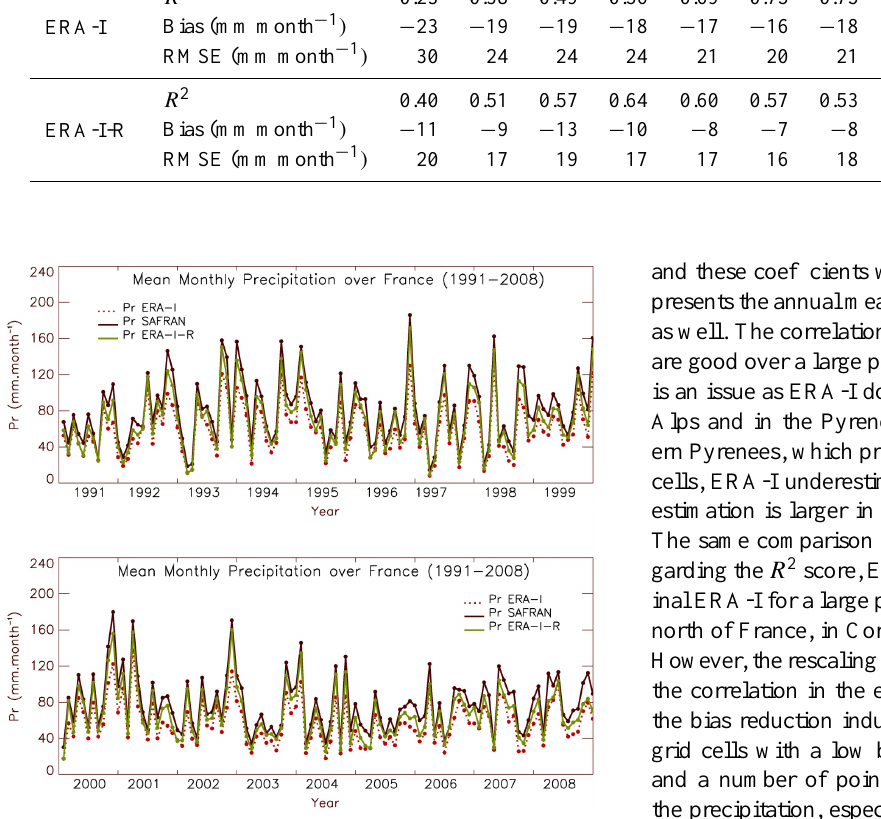
Fig. 3. Mean monthly precipitation over France for SAFRAN, ERA-I and ERA-I-R over the period 1991–2008: from (top) 1991 to 1999, and from (bottom) 2000 to